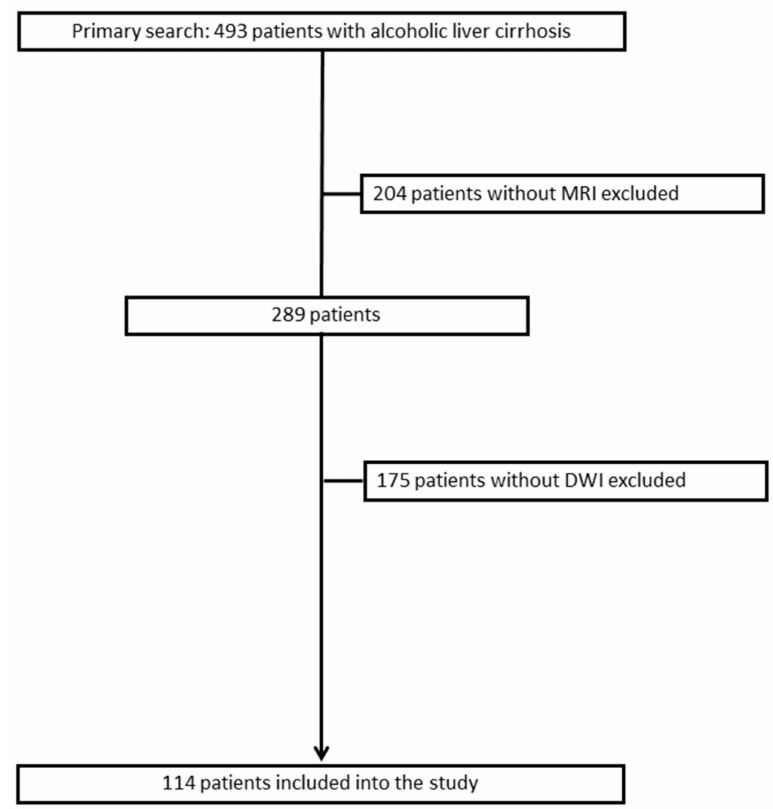
Figure 1. Flowchart of the data acquisition for the present